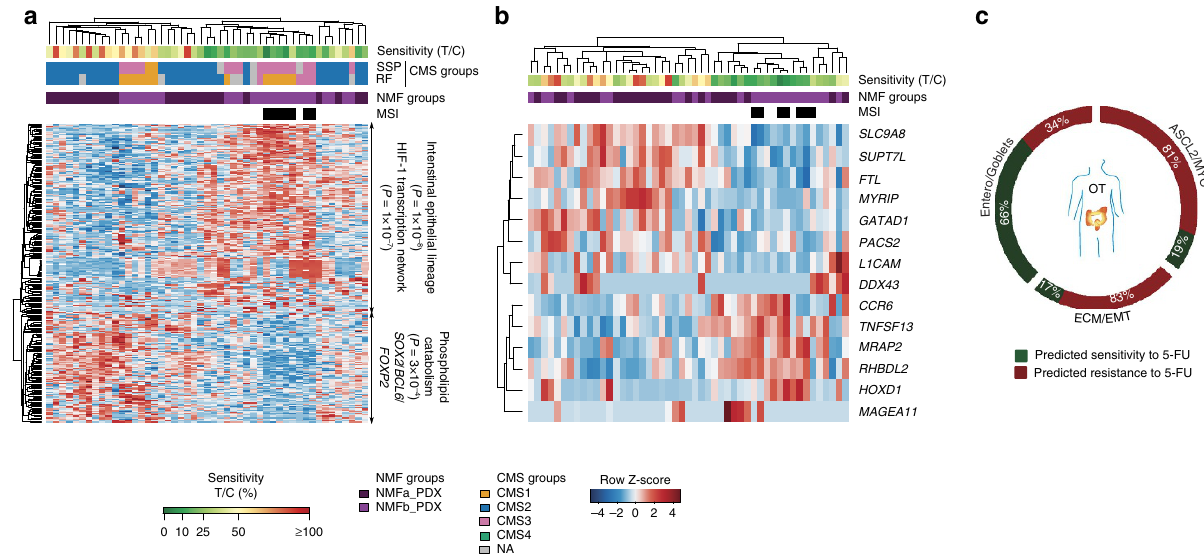
Figure 8 | Molecular classification of response to 5-FU in PDX models. ( a ) Hierarchical clustering of PDX samples based on the 5-FU response gene signature ( n ¼ 251 genes). The drug sensitivity is given by T/C continuous values coloured as indicated in the caption (dark green: strong response, red: resistance). MSI samples, OT-NMF-groups and CMS classifications are coloured as indicated in the caption. ( b ) Hierarchical clustering of PDX samples based on the mini-classifier ( n ¼ 14 genes) obtained by SVM-based machine learning on 49 PDX. (see Supplementary Data 14 for cross-validation). ( c ) Distribution of the predicted responders and resistant patient tumours (tumour purity Z 40%) in the three molecular groups (ECM/EMT, ASCL2/MYC,